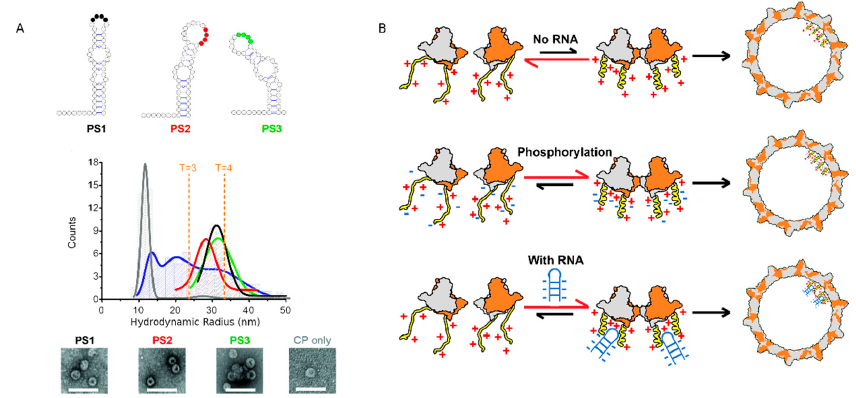
Figure 8. High-affinity binding site (preferred site, PSs) trigger sequence-specific Viral Like Particle (VLP) assembly. ( A ) Dye end-labeled RNA oligos, encompassing PS1 (black), PS2 (red) or PS3 (green), were each assessed for their ability to form VLPs at nanomolar concentrations using single molecule Fluorescence Correlation Spectroscopy (smFCS). PS oligonucleotides were present at a concentration of 15 nM. FCS data were collected in 30 sec bins, and data collected after the addition of 250 nM HBc dimers (taken to be the endpoint of assembly) were then plotted as hydrodynamic radial distributions (middle panel). Unlabeled RNA oligos, encompassing PS1 (blue) and HBc alone (gray), were also assessed for the ability to form VLPs at identical concentrations. At the end of these reactions (after the addition of 250 nM Hbc dimers), HBc was labeled with Alexa Fluor-488 and FCS data were collected in 30 sec bins for 100 min. The resulting R h distributions were plotted as above. Note, the dye-labeling of the HBc dimers prevents them from assembling, implying that this is an end-point measurement. The successful assembly of T = 4 VLPs results in a labeled species of R h ~33–38 nm, as seen by TEM, in assemblies with PS oligonucleotides (lower panel). HBc only assembles predominantly in species with an R h of 10–11 nm (gray), suggesting that the self-association of dimers